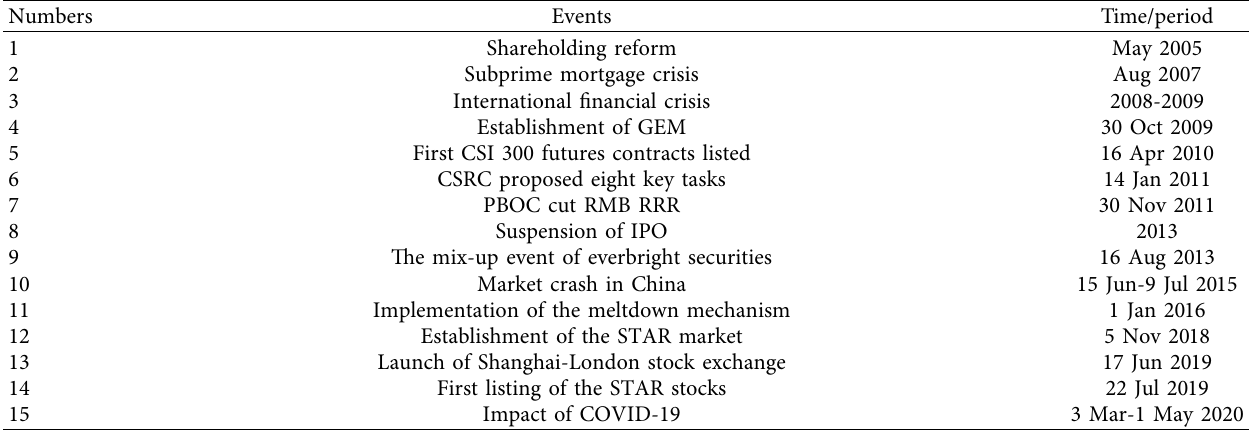
Figure 5: Type (ii) curvature time series. Table 3: List of some market events between 2005 and